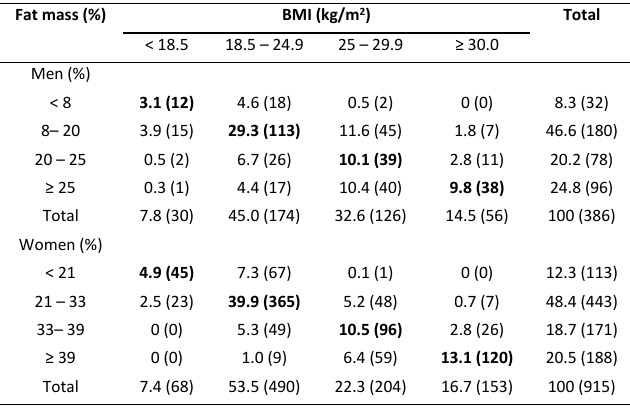
BMI: body mass index. Results are expressed as percentage and number of individuals. Table 3: Comparative summary of studies proposing new cutoff points for the BMI for the classification of overweight/obesity in men and women.